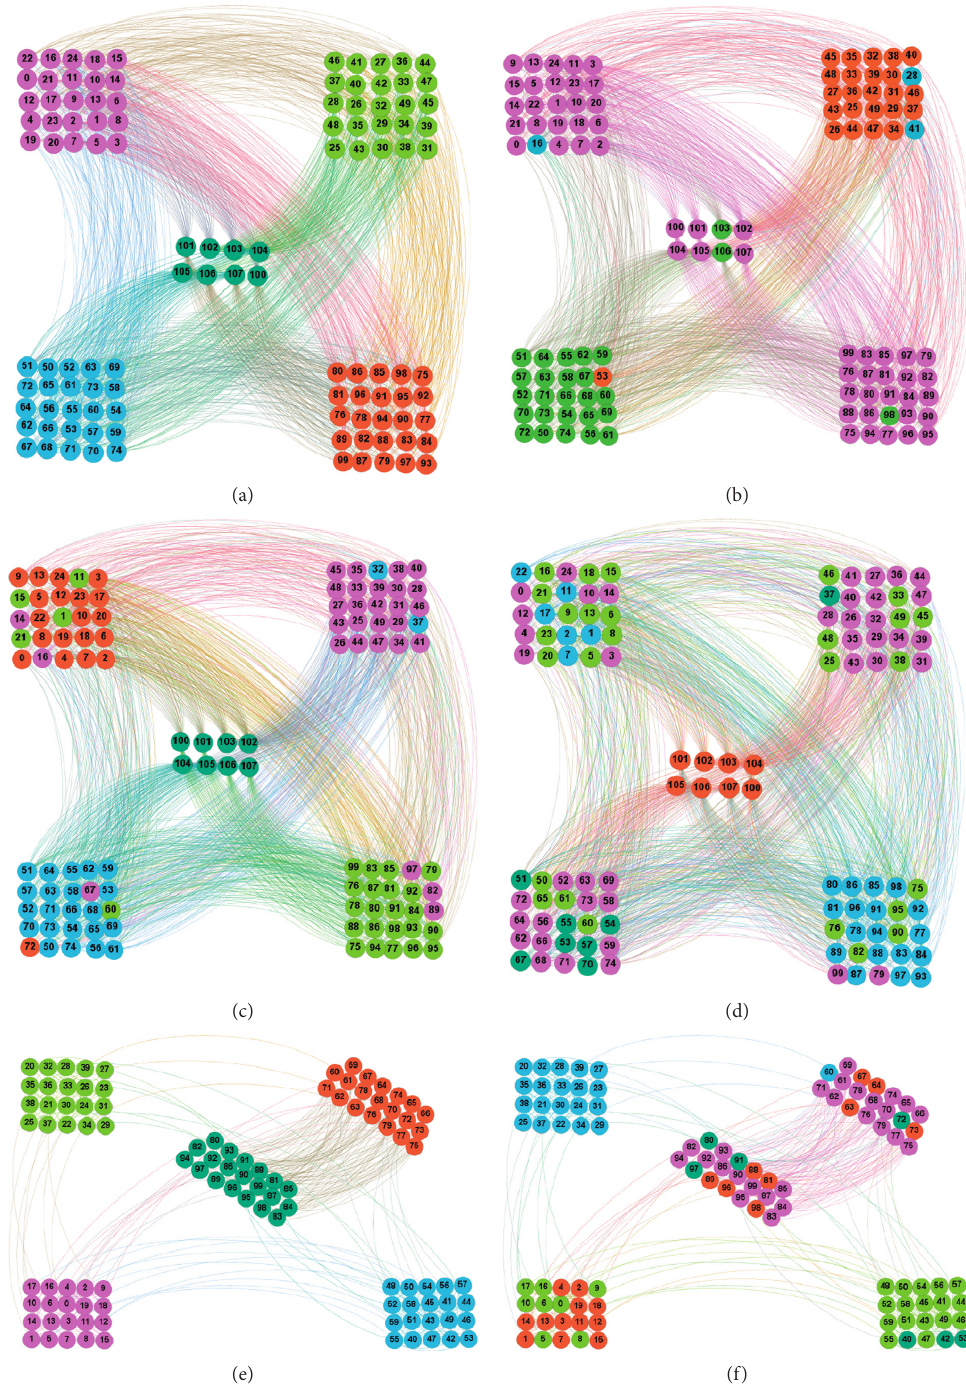
Figure 6: Communities detected by GSC and NEMBP models on two synthetic networks. (a) The real community assignment of the synthetic network of 108 nodes. (b) The result of community detection by GSC-link. (c) The result of community detection by GSC, ρ a � 0 . 5. (d) The result of community detection by NEMBP, ρ a � 0 . 5. (e) The real community assignment of the synthetic network of 100 nodes. (f) The result community detection by NEMBP. The nodes of the same communities are in the same